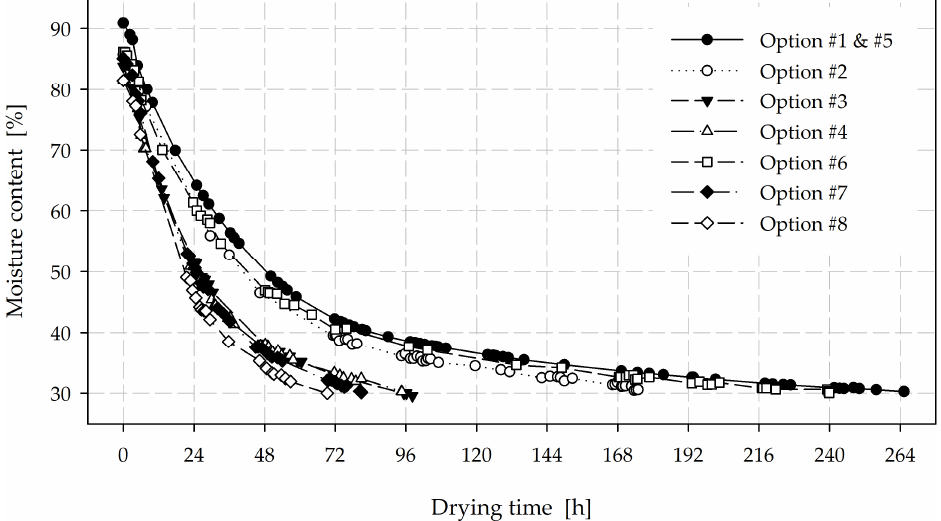
Figure 2. Comparison of drying curves for various drying schedules.